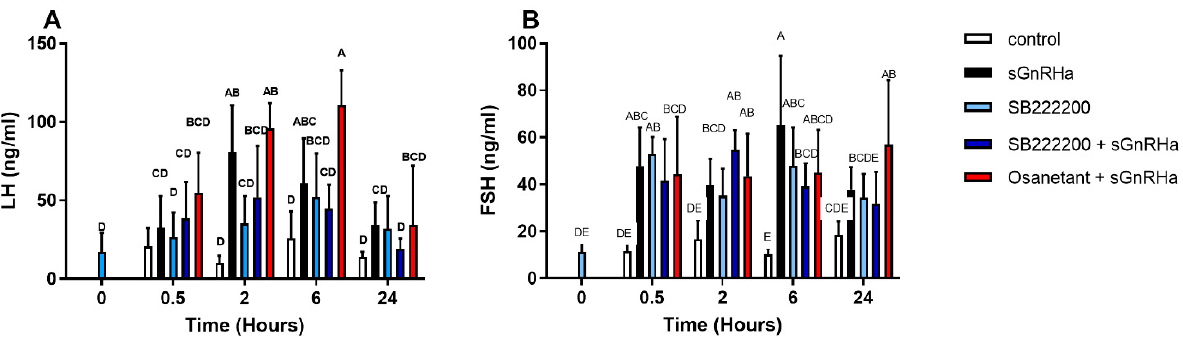
Figure 8. Showing In vivo effect of NKB antagonists, SB-222200, and Osanetant, on LH ( A ) and FSH ( B ) plasma levels. Male tilapia were IP injected with NKB antagonists (100 µ g/kg BW) and after 0.5 h, a second injection of sGnRHa ([DAla 6 ,Pro 9 -Net]-mammalian GnRH; Bachem) 10 µ g/kg BW) was added. Control groups were injected with sGnRHa (10 µ g/kg BW) as a positive control, and saline. Plasma LH and FSH values were analyzed by specific ELISA (Mean with 95% CI; n = 10 fish per group). Columns marked with different letters are significantly different (two-way ANOVA followed by Tukey HSD) .